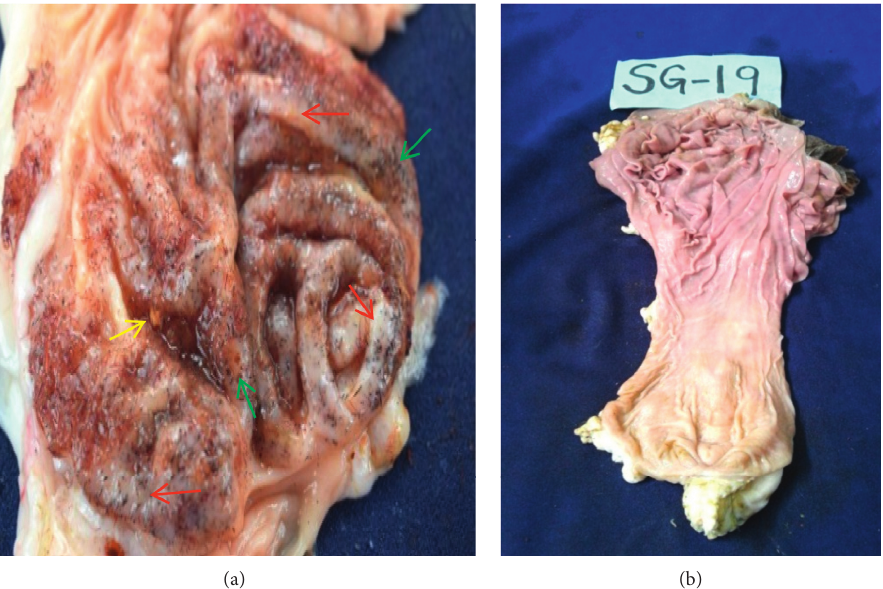
Figure 9: (a) Abomasitis showing severe inflammation characterized by swollen folds with edema, abscesses (red arrows), Opuntia stricta seeds lodged between folds (yellow arrow), and numerous thorns and spines (green arrows) of a goat that had consumed Opuntia stricta . (b) Abomasum of a goat that had not consumed Opuntia stricta showing clean fundus, corpus, and pyloric areas, free of thorns and